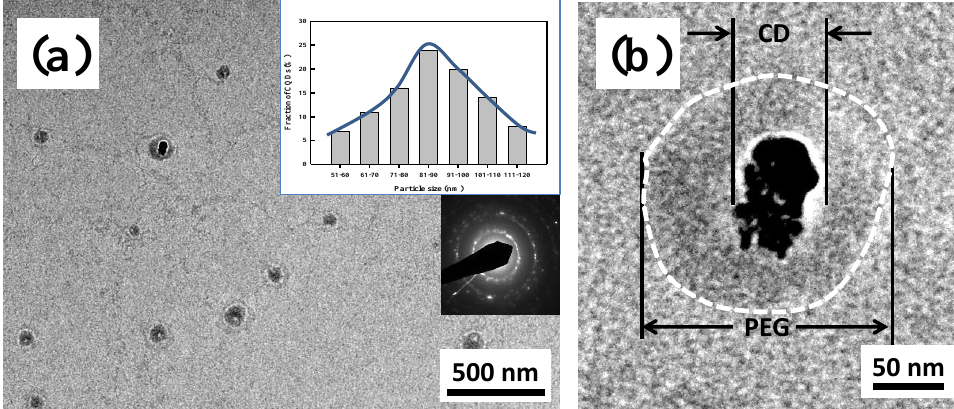
Figure 1. High-resolution transmission electron microscope (HR-TEM) micrographs of polyethylene glycol 6000 / carbon nanodots (PEG 6000 / CDs) particles with low ( a ) and ( b ) high magnification. The inset shows the particle size distribution and the selected-area diffraction pattern on the PEG 6000 /CD particles.